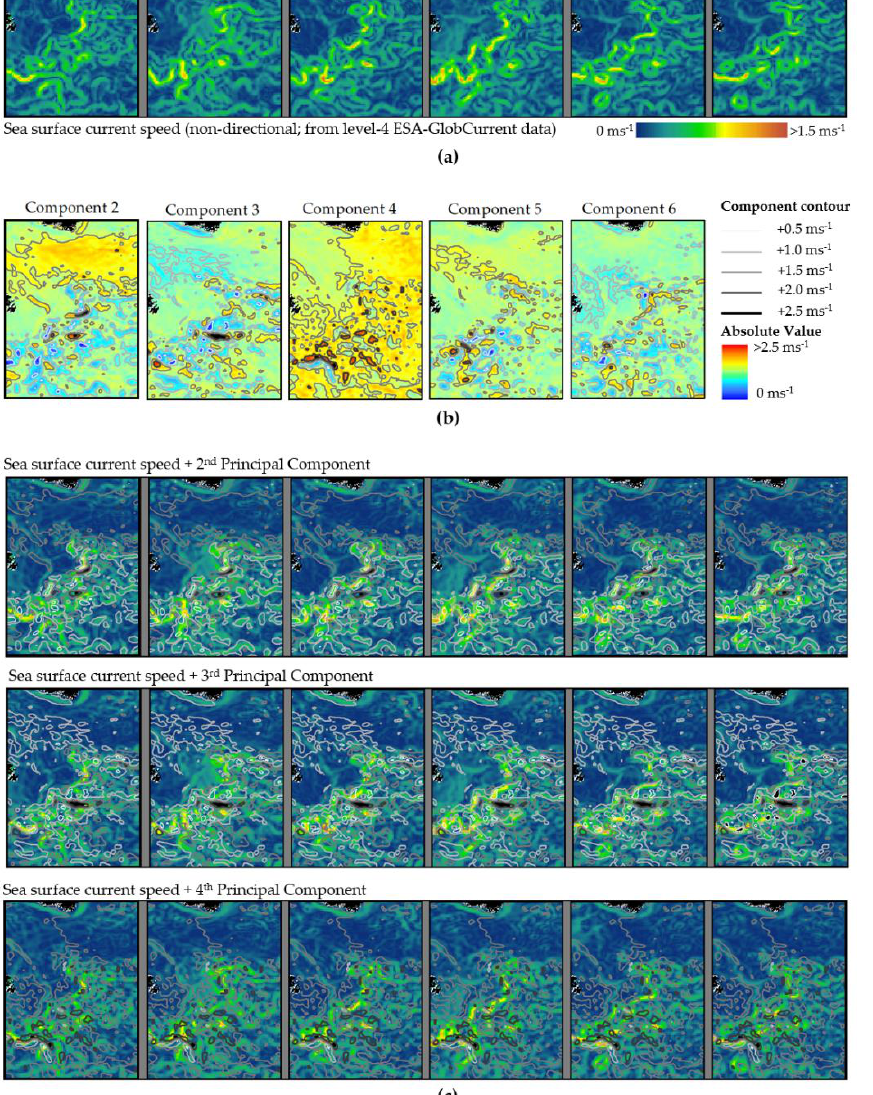
Figure 5. Challenges faced by principal components analysis in highlighting mobile mesoscale ocean features in the Grand Banks region of the North Atlantic. ( a ) The evolution of a suspected eddy structure in a subsample of a year-long 7-day interval hypertemporal dataset of level-4 absolute geostrophic speed. ( b ) The imaged and contoured components 2–6 of a principal components analysis of the year-long hypertemporal dataset. Together with component 1, they represent over 86% of the variability contained within the dataset. ( c ) Contoured components 2–4 overlying the sea surface speed imagery, demonstrating the lack of delineation of the feature highlighted in panel ( a ). The speed data have been resolved from a level-4 dataset of geostrophic velocity data produced by the ESA-GlobCurrent initiative and made available through the Copernicus Marine Core Service.